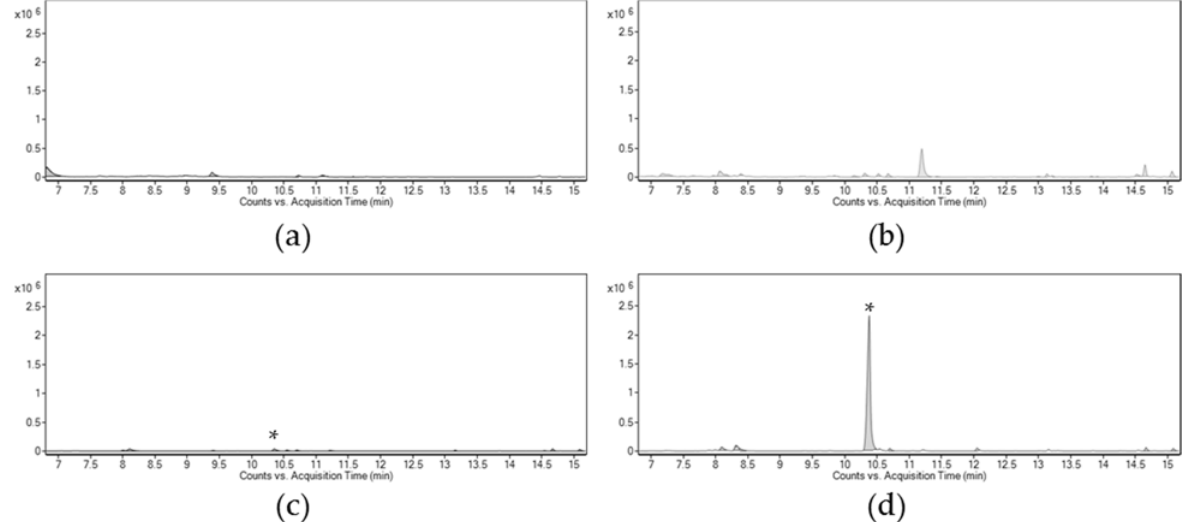
Figure 2. Gas chromatography-mass spectrometry profiles of volatile blends produced by different odor sources. ( a ), soursop, ( b ), insect females feeding on soursop, ( c ), non-feeding males, and ( d ), males feeding on soursop. * indicates the presence of an exclusive peak at 10. 34 min found in males and increased when males feed on soursop.